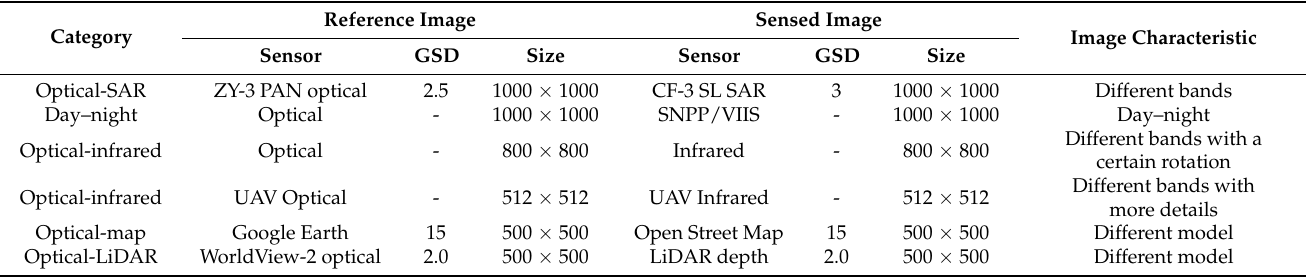
Table 2. Description of test